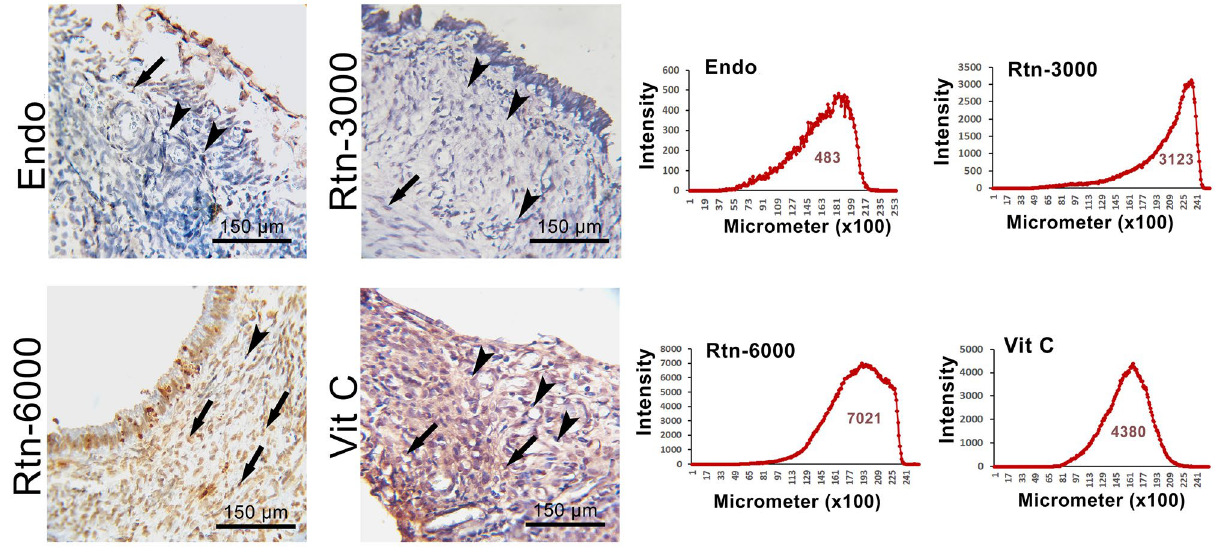
Figure 3. TUNEL staining of ectopic endometrial tissue. Note increased apoptotic cells in vitamin C-treated and Rtn-6000-treated groups compared to control and other experimental groups. The software analyses of the pixel-based intensity of brown reaction (representing TUNEL reaction) in 25,200 × 25,200 µm of tissue in different groups are presented. As shown, the section from the control group represents the lowest and the section from Rtn-6000 and Vit C are representing the highest TUNEL reactions, respectively.